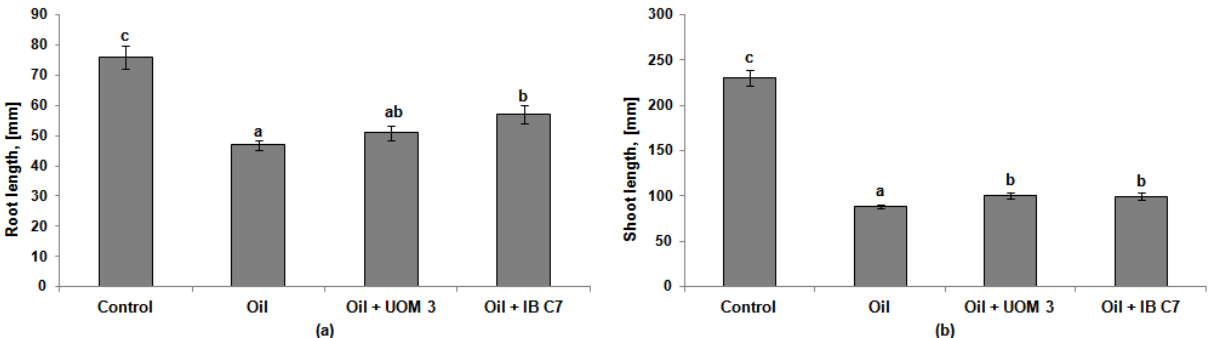
Figure 1. Root ( a ) and shoot ( b ) length of barley plants 10 days after germination. UOM 3 and IB C7, variants of experiments with introduction of Enterobacter sp. UOM 3 and P. hunanensis IB C7, respectively. Statistically different means values for each indicator ( n = 15) are marked with different letters ( p ≤ 0.05). Table 1. The mass of shoots and roots of barley plants 10 days after germination, mg .